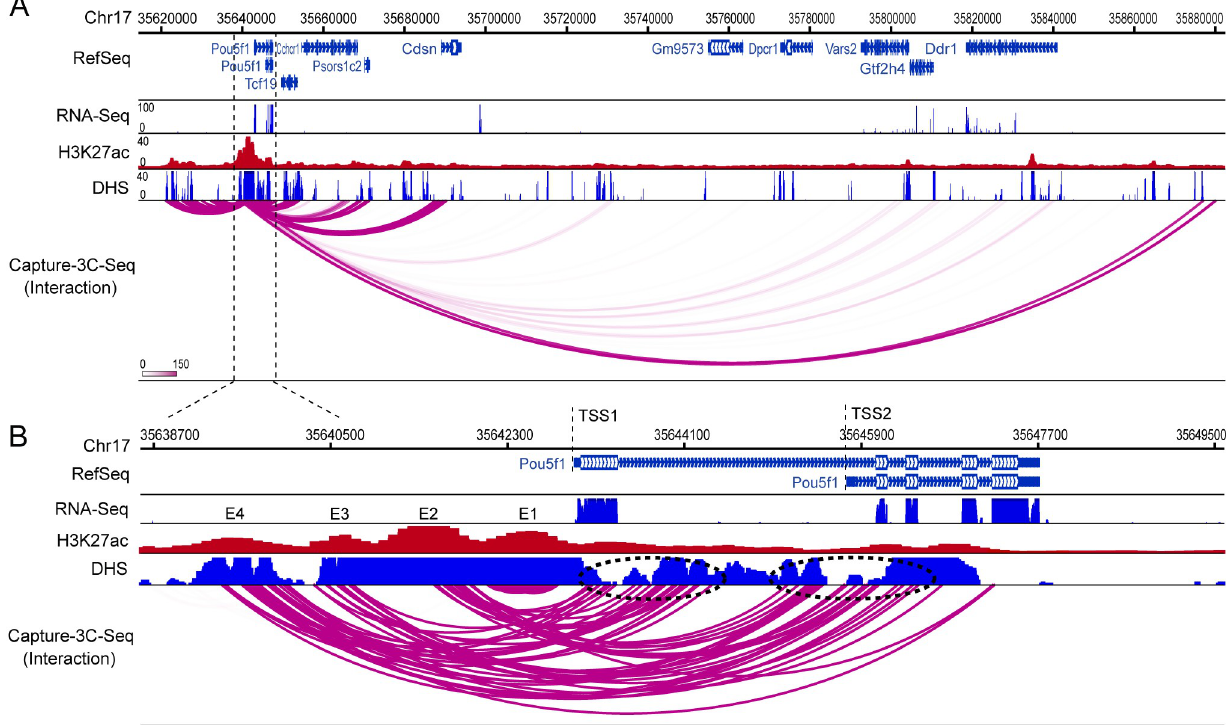
Fig 5. Detecting chromatin interactions associated with the OCT4 super-enhancer in mESCs. A . The zoom-out view of the captured chromatin interactions at the OCT4 super-enhancer region (Chr17:35620000–35688000). B . The zoom-in view of the captured chromatin interactions at the OCT4 super-enhancer. The dotted ovals show two distinct promoter regions (TSS1 and TSS2) associated with clustered interactions with discrete constituent enhancer (E1 to E4) (Chr17:35638700–35649500).